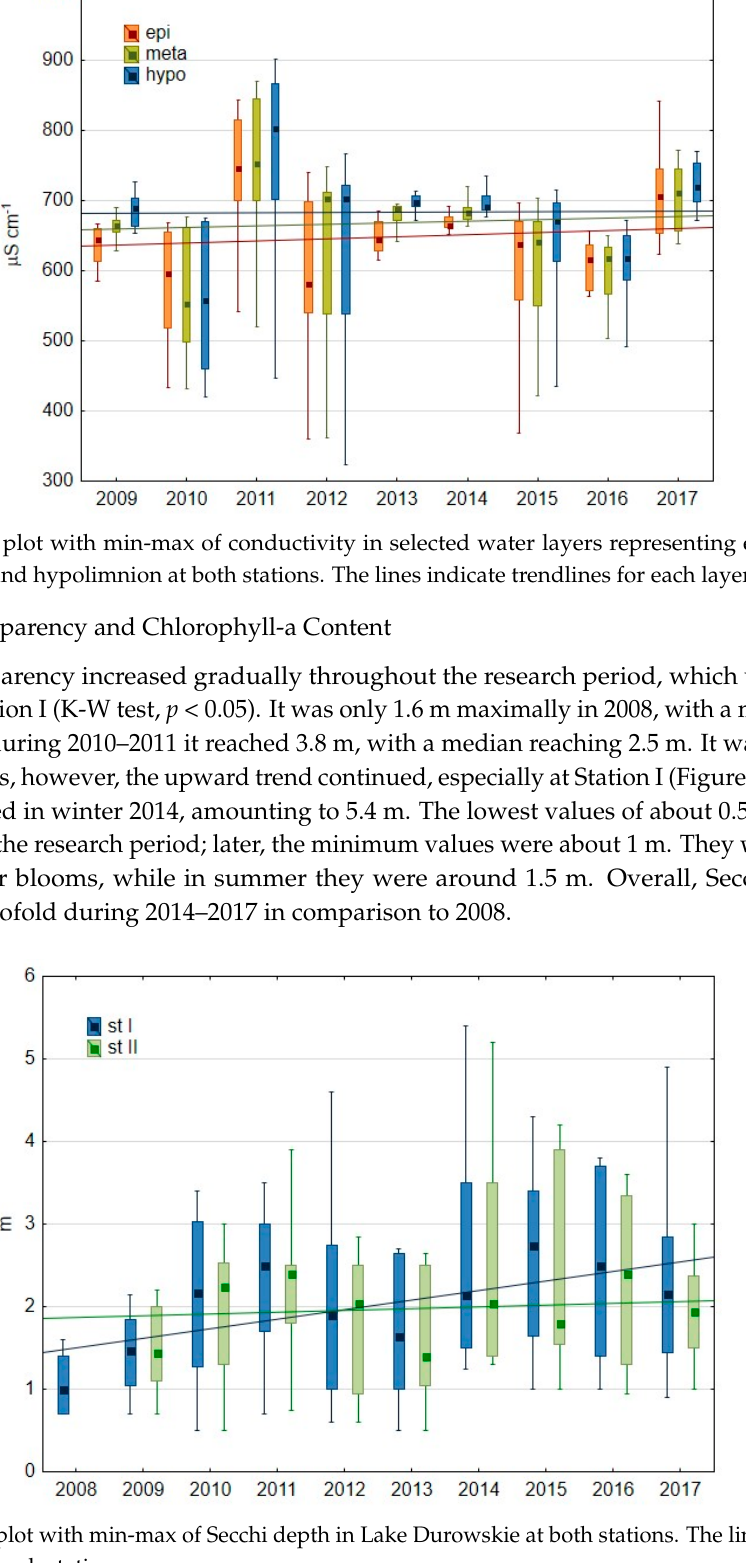
Figure 7. Box plot with min-max of chlorophyll-a in epilimnion at both stations I. The lines indicate exponential trendlines for each station. 3.1.3. Nitrogen Concentrations Among nitrogen compounds, mineral ones, mainly ammonium N and nitrates were dominant. The mean contribution of mineral forms in total N was 60.5%, while the highest was 72.4% in 2011. It is characteristic that, as a result of the beginning of restoration, concentration of ammonium nitrogen increased very markedly, especially in the hypolimnion (Figure 8a,b). It reached maximum values at the end of summer thermal stratification, especially at deeper Station I, maximally up to 8.49 mgN- NH 4 L − 1 (2012). During restoration a statistically significant decrease of ammonium N content in subsequent years was observed in all water layers at both stations (K-W test, p < 0.01). Median reduction in the epilimnion was from over 1 mgN L − 1 in 2009 to less than 0.4 mgN L − 1 in 2017, while in the hypolimnion—from over 1.9 to less than 0.6 mgN L − 1 . It was thus on average about 30% lower during 2013–2017 in comparison to 2008. Nitrate concentration, on the other hand, fluctuated during the research period. During 2008–2010 and 2014–2016, it was less than 2 mgN-NO 3 L − 1 , with a median